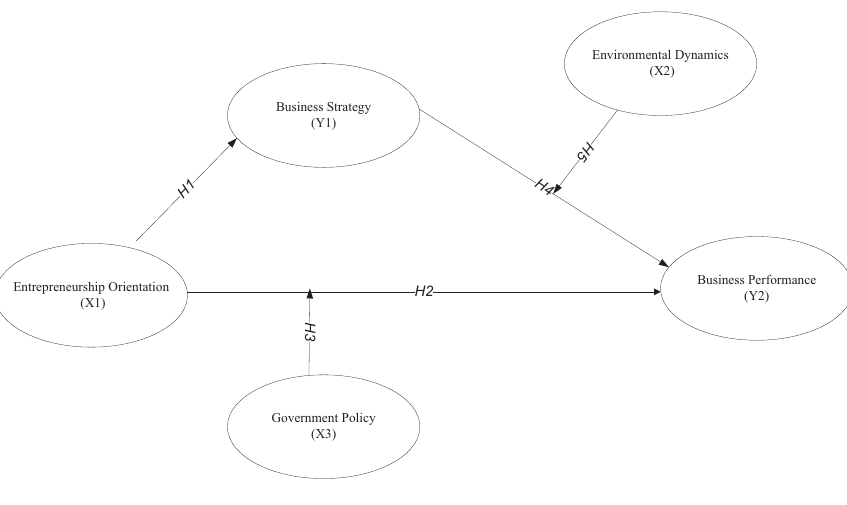
Figure 1. Research conceptual